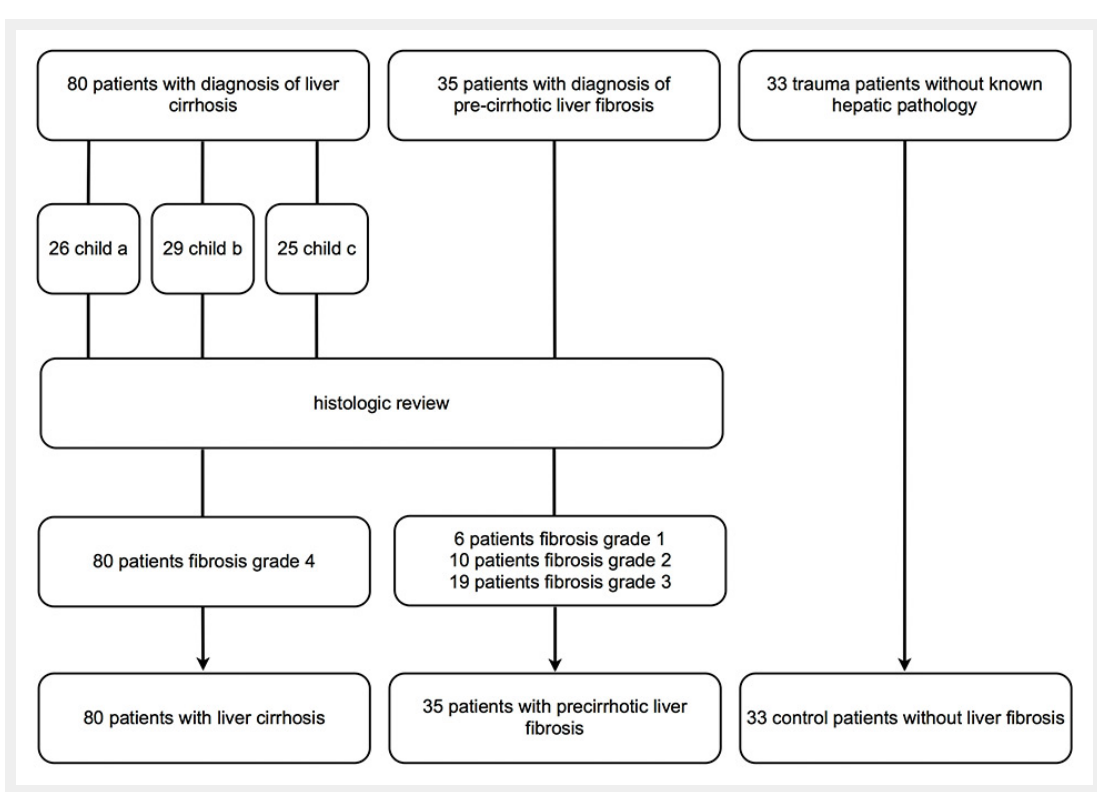
Figure 1 Patient population. Abdominal computed tomography scans of 148 patients were retrospectively analysed. Included were 80 patients with liver cirrhosis, 35 patients with earlier liver fibrosis and 33 control patients without known liver disease.